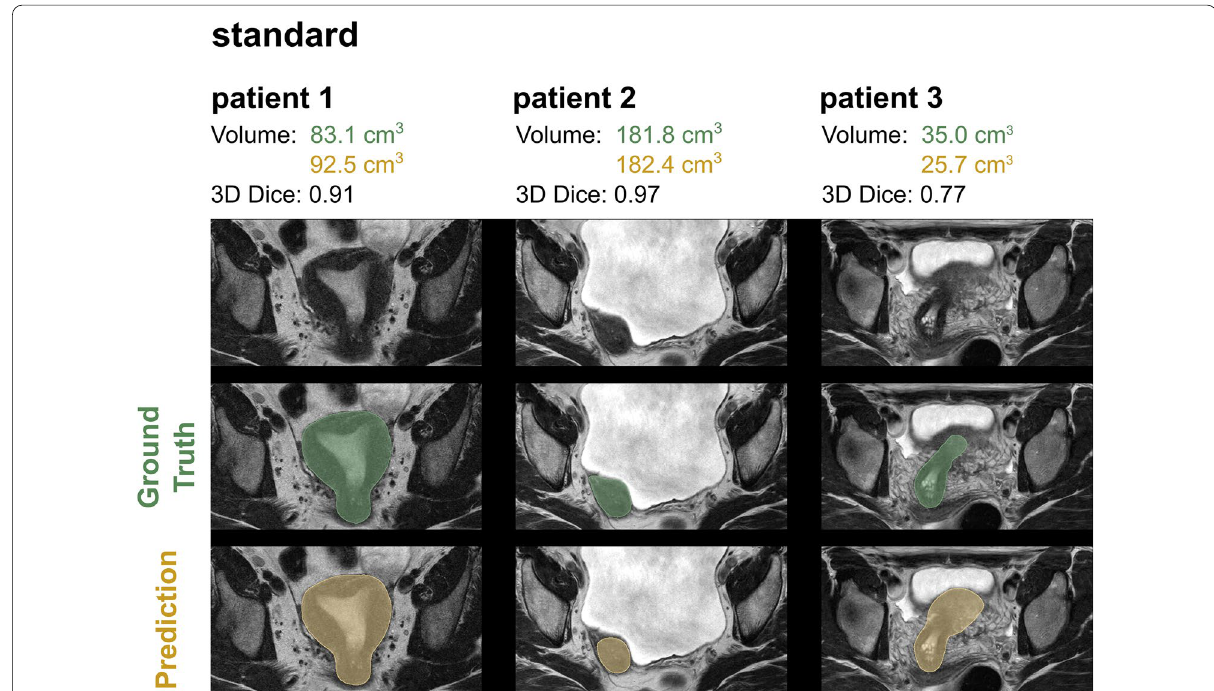
Fig. 3 Predicted uterine segmentation of the default 3D nnU-Net (yellow) and the ground truth segmentation verified by the board-certified radiologist (green) of three different patients in the standard group without uterine fibroids